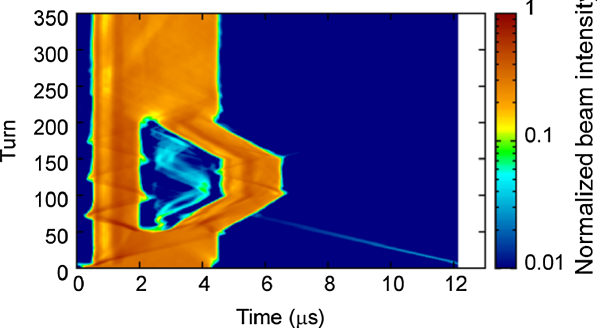
FIG. 9. Evolution of the beam intensity profile in the offDBB (simulation).